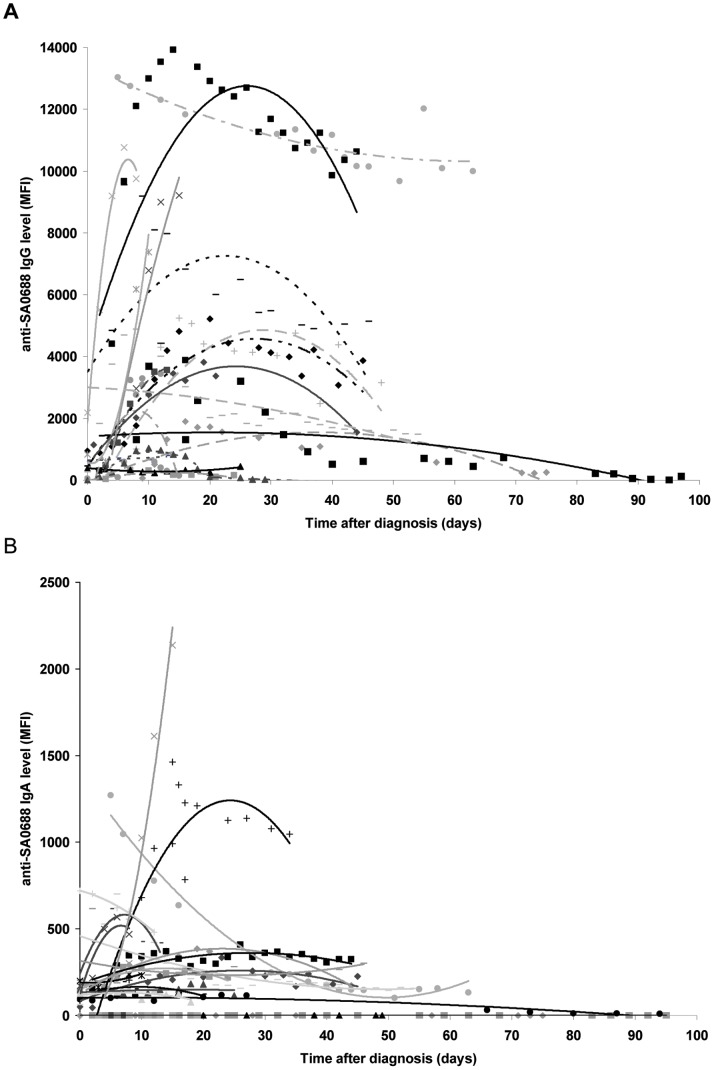
Antibody courses against the antigen SA0688 in bacteremia patients.A: Courses of anti-SA0688 IgG levels in 21 bacteremia patients. Each data point represents the average of duplicate Luminex measurements expressed as the mean fluorescence intensity (MFI). Each patient is represented by a serial set of the same symbols and a polynomial trend lines is drawn through this set. B: Course of anti-SA0688 IgA levels in 21 bacteremia patients. Note that the MFI values on the Y-axis are a factor of 10 lower than in Figure 2A.